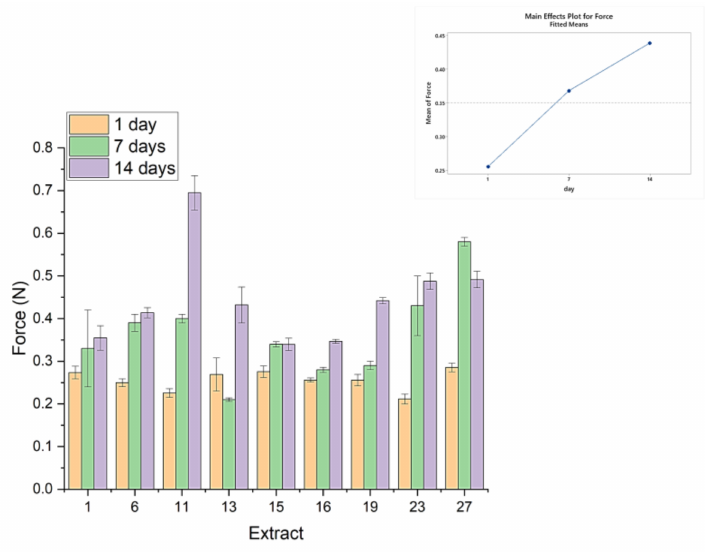
Figure 5. Deformation energy of yogurts in the first day (expressed as area of the Force–Time plot), after one and two weeks.